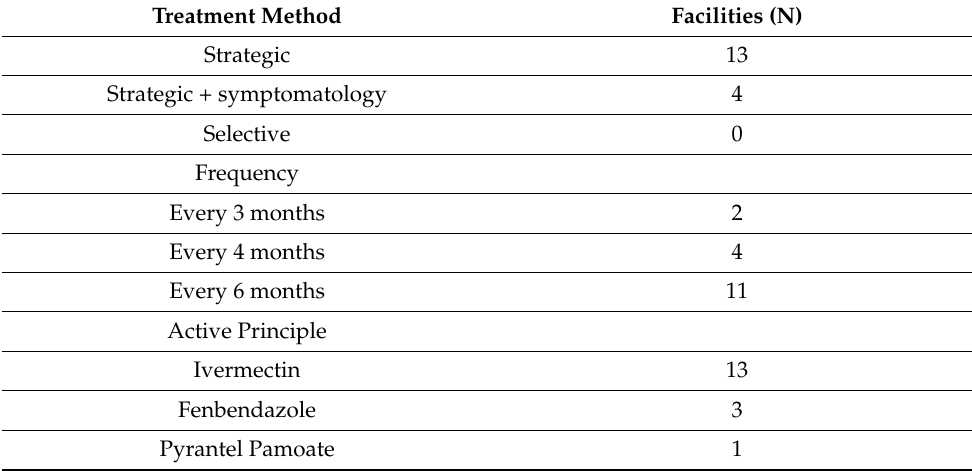
Table 1. Anthelmintic drug usage (treatment criteria, frequency and active principle) is reported for each facility (N = number of facilities) enrolled in the study. Treatment Method Facilities (N)